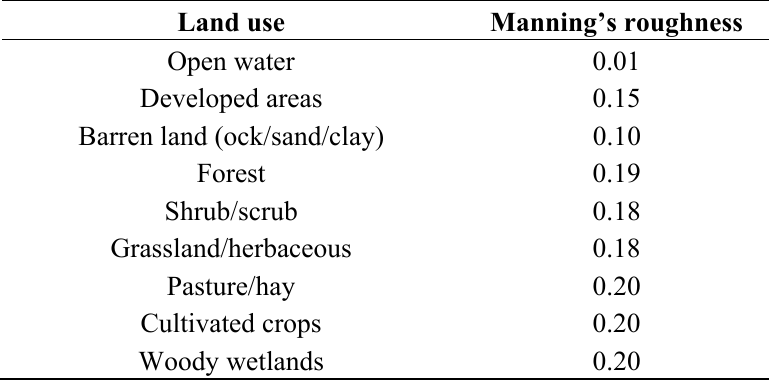
Table 5. Manning’s surface roughness values used in this study for different land